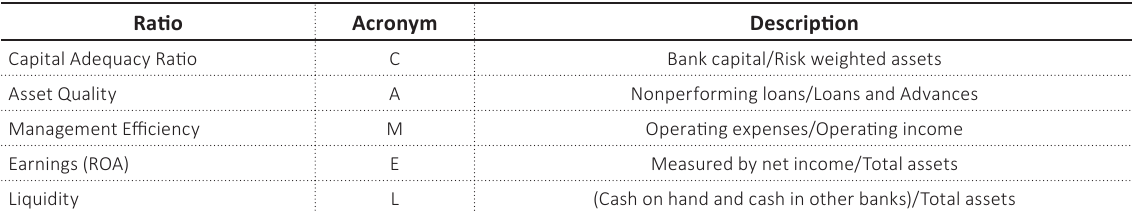
Table 2. Ratio-based model (CAMEL)